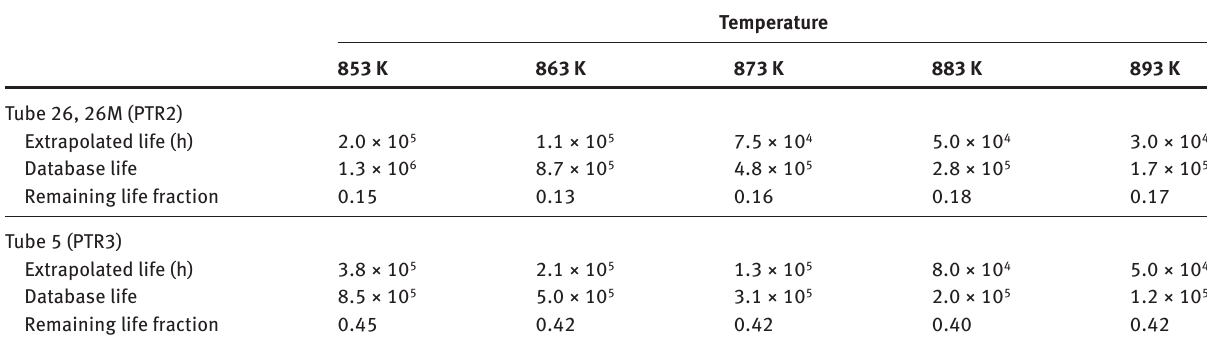
Table 11: Comparison of time to rupture for service exposed material and data base predictions and remaining life fraction